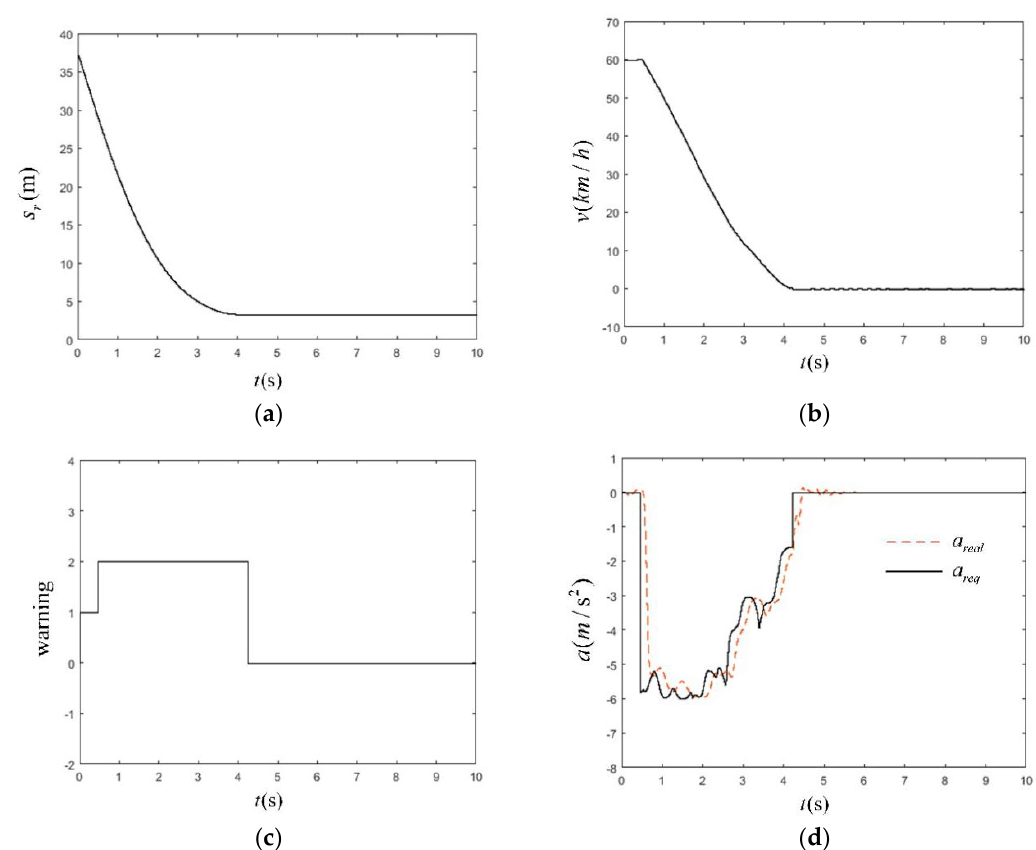
Figure 26. The simulation time as a function of station ( a ), velocity ( b ), warning signal ( c ), deceleration of the vehicle ( d ) in CVFA-25 scenario under high-speed working conditions.